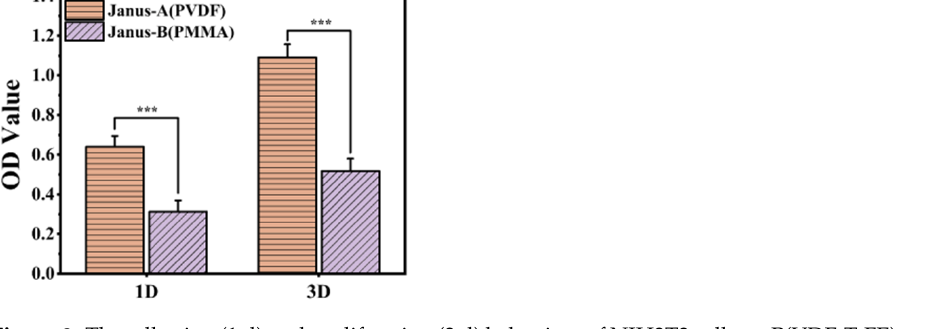
Figure 3. The adhesion (1 d) and proliferation (3 d) behaviors of NIH3T3 cells on P(VDF-TrFE) coating and PMMA film (*** p < 0.001).